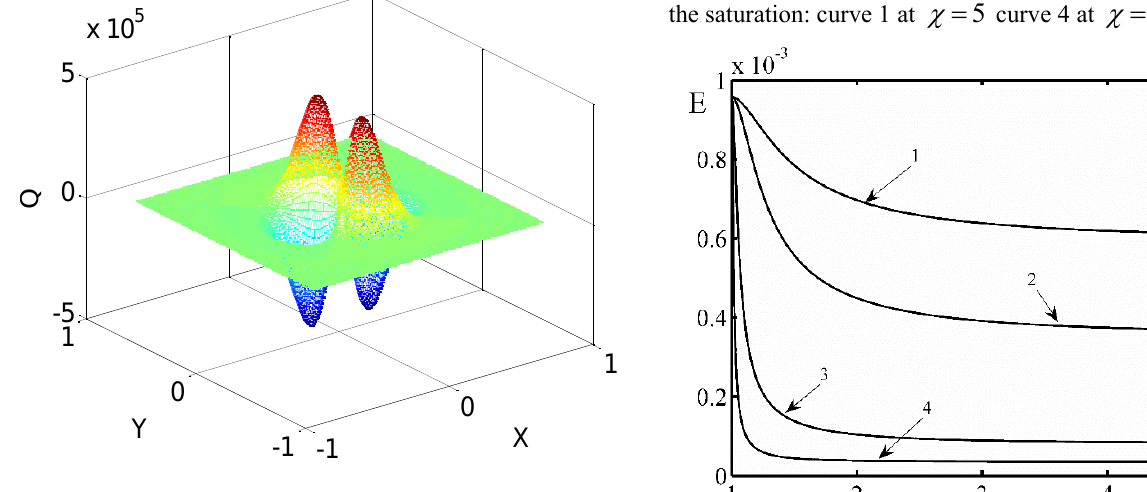
Figure 2: The second Stokes parameter versus distances between observation points.